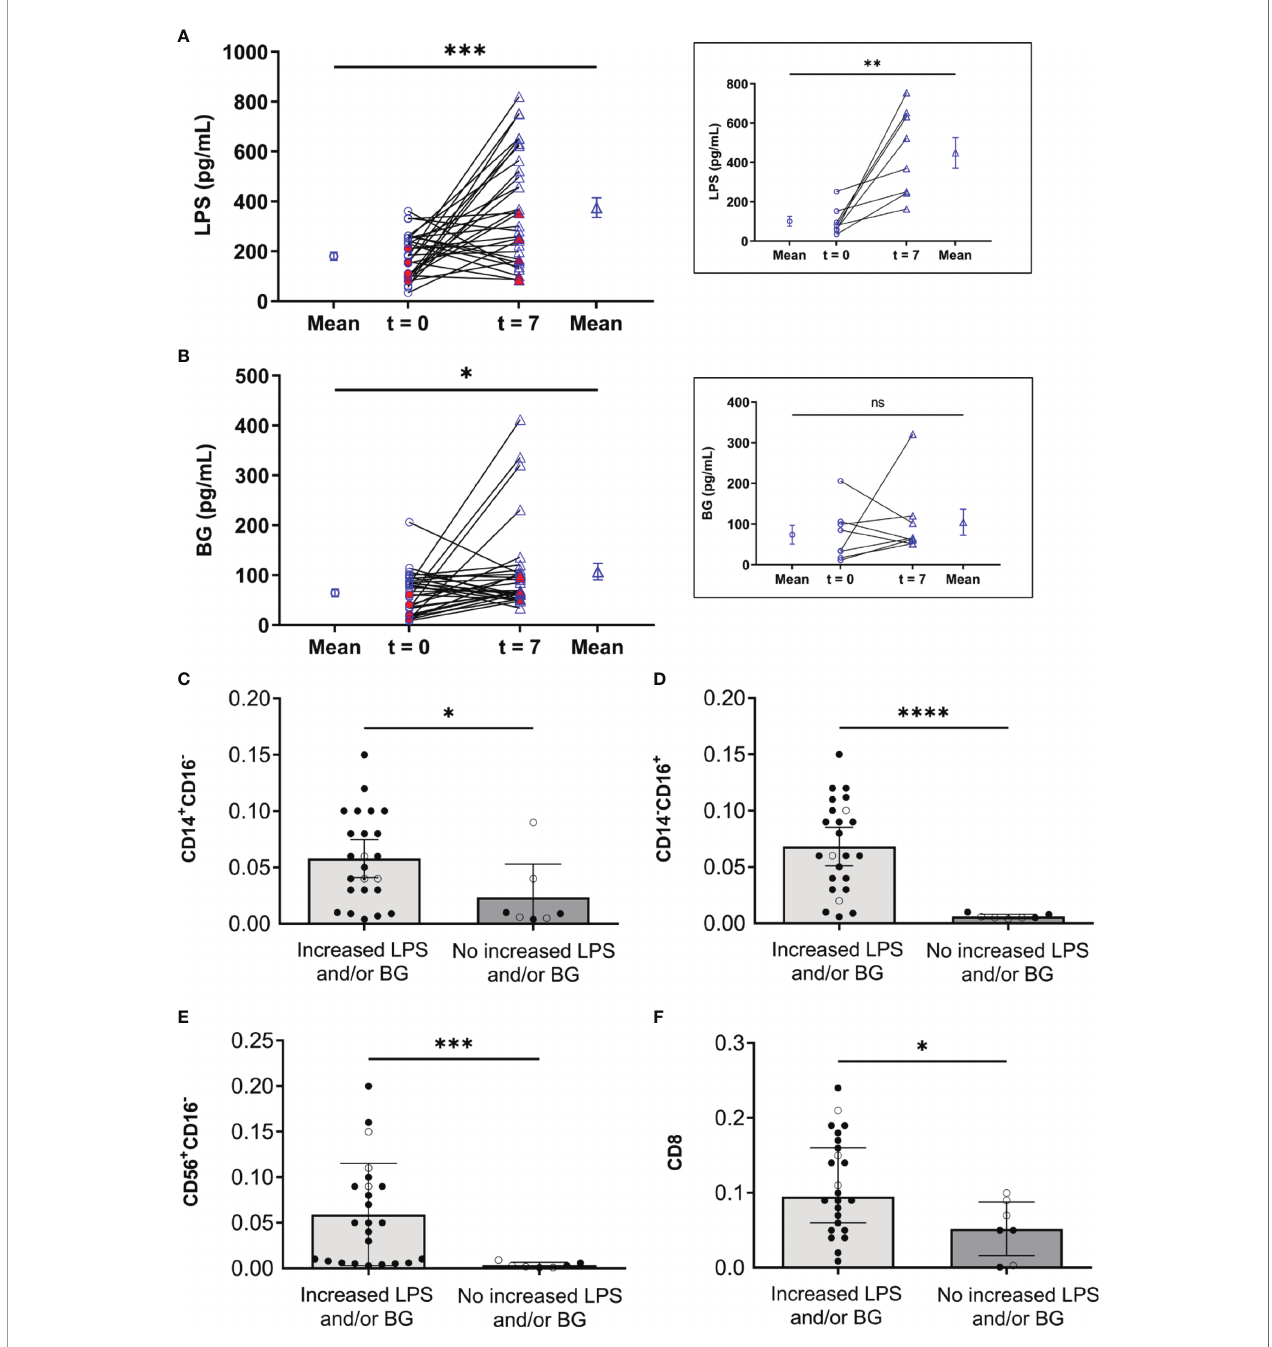
FIGURE 3 | Roles of lipopolysaccharide (LPS), (1 ! 3)- b -D-glucan (BG), and innate immunity parameters. (A) The difference of lipopolysaccharide (LPS) and (B) (1 ! 3)- b -D-glucan (BG) between time enrollment (t = 0, ○ ) and day 7 of illness (t = 7, D ) in dengue patients with impaired intestinal permeability (n = 31). The red dots in A and B represent patients with clinical severe dengue (plasma leakage, bleeding, or organ involvement; see method) during the observation. The inset boxes are value of LPS (inset box in A) and BG (inset box in B) in serum at t = 0 and t = 7 in patients who developed from febrile phase (1st through 3rd day of illness) to critical phase (4th through 7th day of illness) of dengue. Paired t-test was used for comparing mean. (C, D) blood abundance of monocytes (CD14 + CD16 - and CD14 - CD16 + ), (E) natural killer cells (CD56 + CD16 - ), and (F) cytotoxic T cells (CD8) strati fi ed by dengue patients with increased LPS and/or BG compared to those without increased LPS and/or BG. (C-F) ○ and ● in C-F refer to non-severe and severe dengue infection cases, respectively. Mann-Whitney U test was used for comparing median. ns, non- signi fi cant, * p < 0.05, **< 0.01, *** p < 0.0005, and **** p <